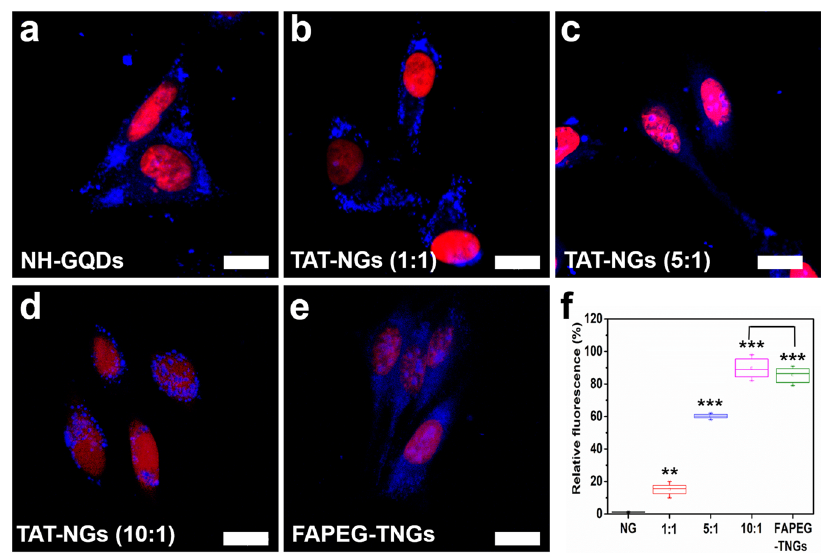
Fig. 3 Fluorescence images of HeLa cells incubated with NH-GQDs derivatives. a NH-GQDs, b TAT-NGs (1:1), c TAT-NGs (5:1), d TAT-NGs (10:1), and e FAPEG-TNGs. f The endonuclear fl uorescence intensity of TAT-NGs and FAPEG-TNGs relative to that of NH-GQDs (the images are overlaid with the blue color of NH-GQDs derivatives and the red color of nuclei stained with 7-aminoactinomycin D (7-AAD, Component B). Scale bars, 20 μ